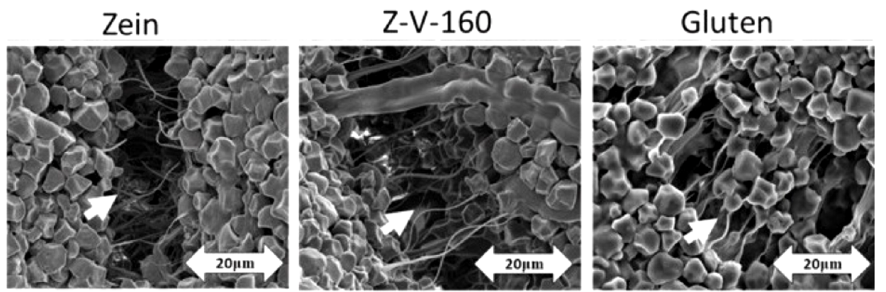
Figure 3. Images of dough samples containing starch with zein, thermally treated-zein (zein heated in vacuum at 160 °C, Z-V-160) and gluten. Adapted from [46]. The white arrows in the image represent the scale - they indicate the distance of 20 m.